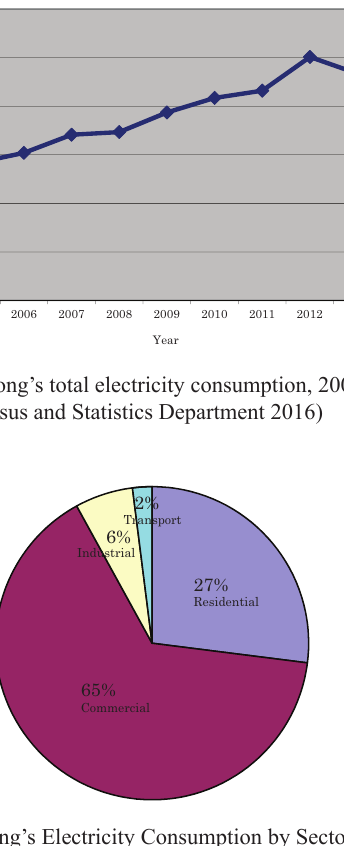
Fig. 2. Hong Kong’s Electricity Consumption by Sector in 2014 (Census and Statistics Department 2016)